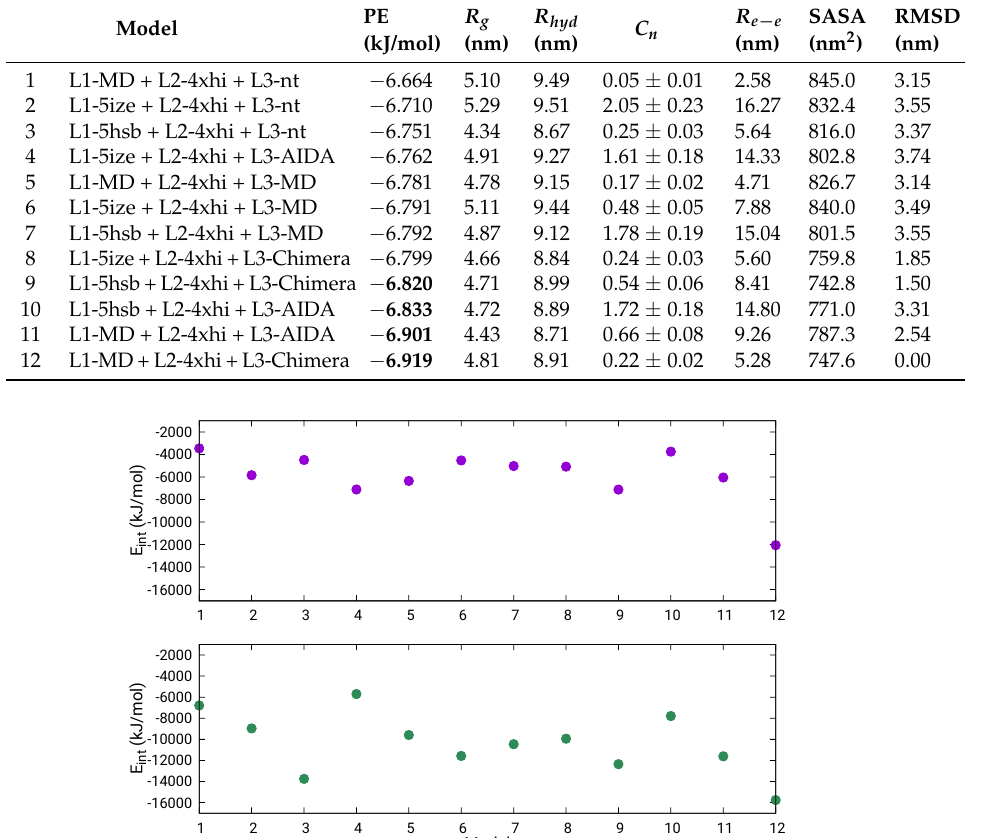
Figure 6. Interaction energy between contiguous domains L1–L2 (magenta) and L2–L3 (green) within the full L protein. Structural models numbered by the order they appear in Table